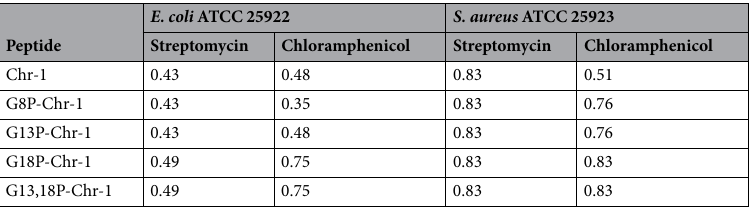
Table 6. Synergy experiments of Chr-1 and its variants in combination with Streptomycin and Chloramphenicol against E. coli and S. aureus as expressed in terms of their FICI values. The MIC values of Chloramphenicol and Streptomycin were 8 μ M and 2 μ M respectively against E. coli ATCC 25922, and their MICs against S. aureus ATCC 25923 were 32 μ M and 8 μ